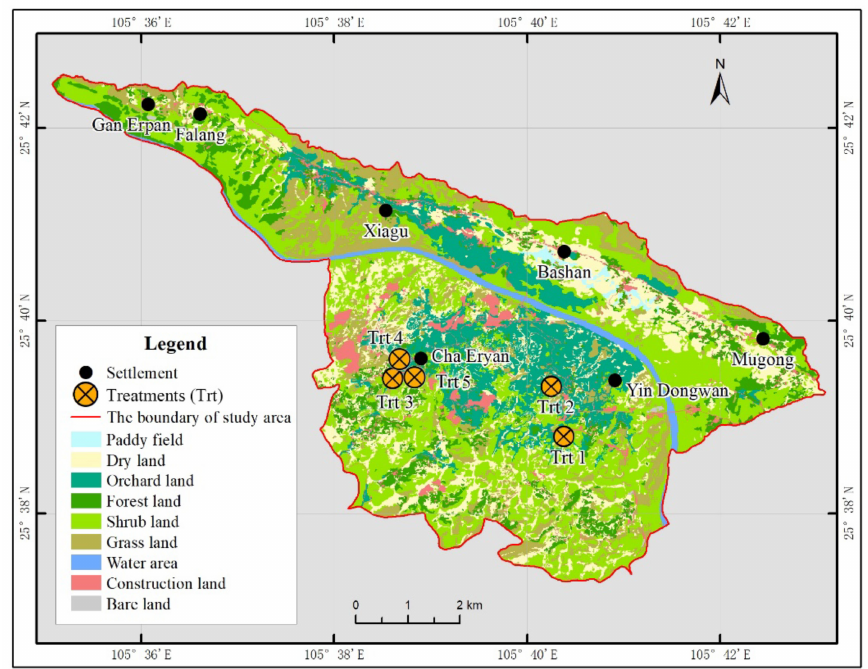
Figure 1. Distribution of treatments